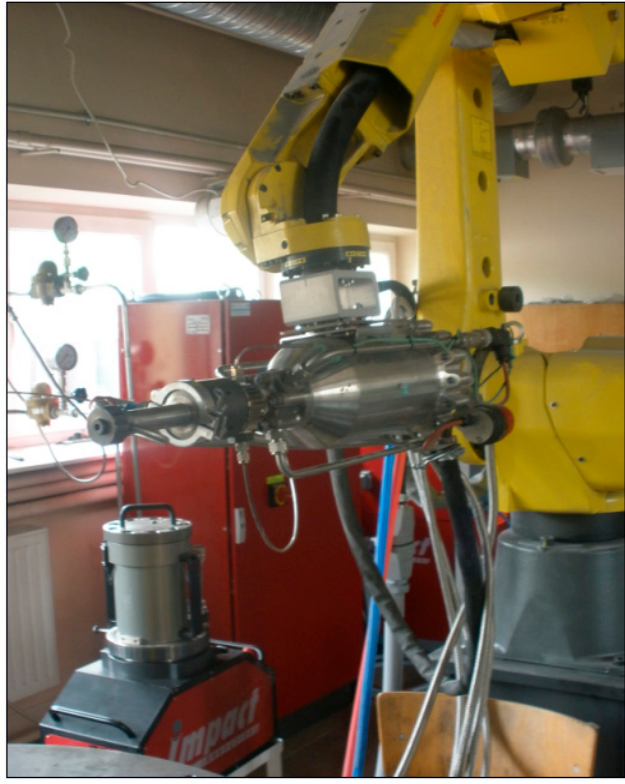
Figure 1. Impact Innovations 5/8 cold spray system.